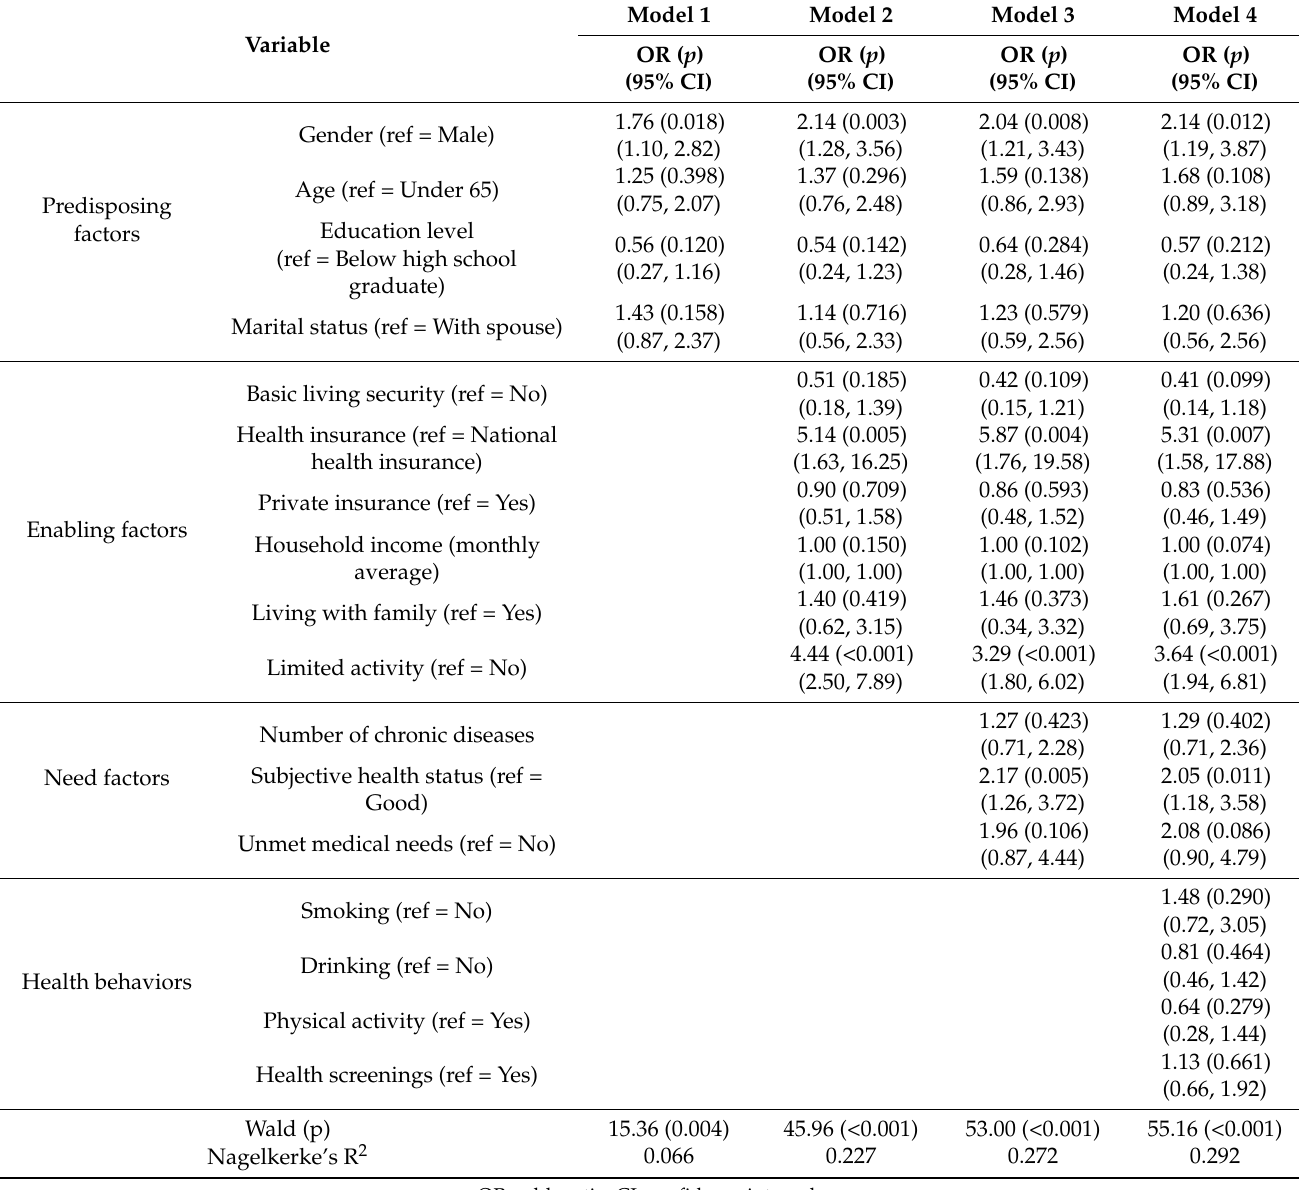
Table 5. Factors affecting pain/discomfort dimension of health-related quality of life in patients with multimorbidity according to Andersen’s model (South Korea,